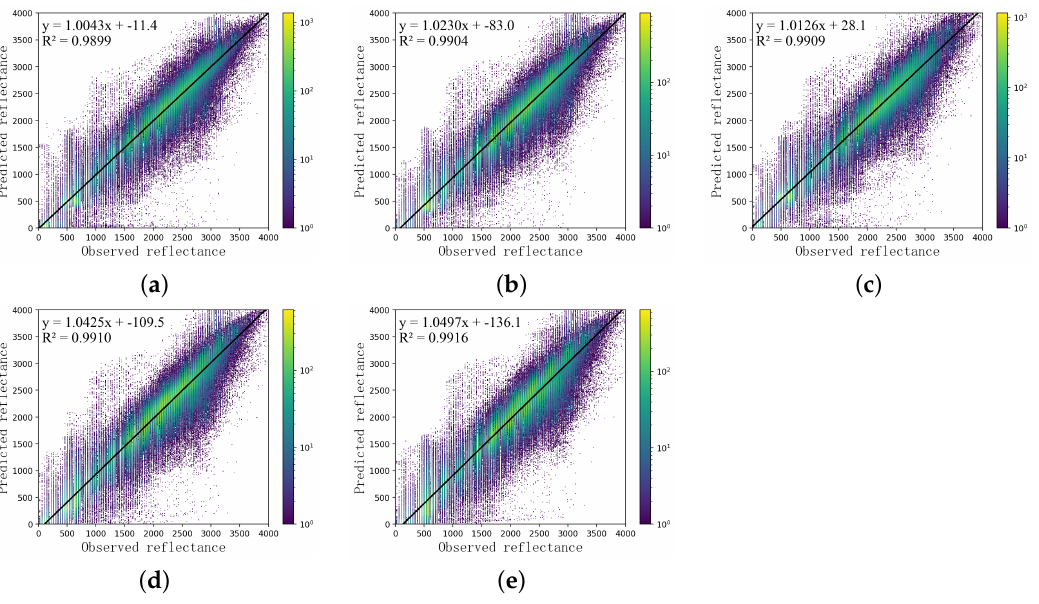
Figure 7. Correlation between NIR band predicted image and real image on 2 March 2005 of LGC. ( a ) baseline. ( b ) baseline + Egloss. ( c ) baseline + Sp-Ca-Att. ( d ) baseline + Mu-scale. ( e )